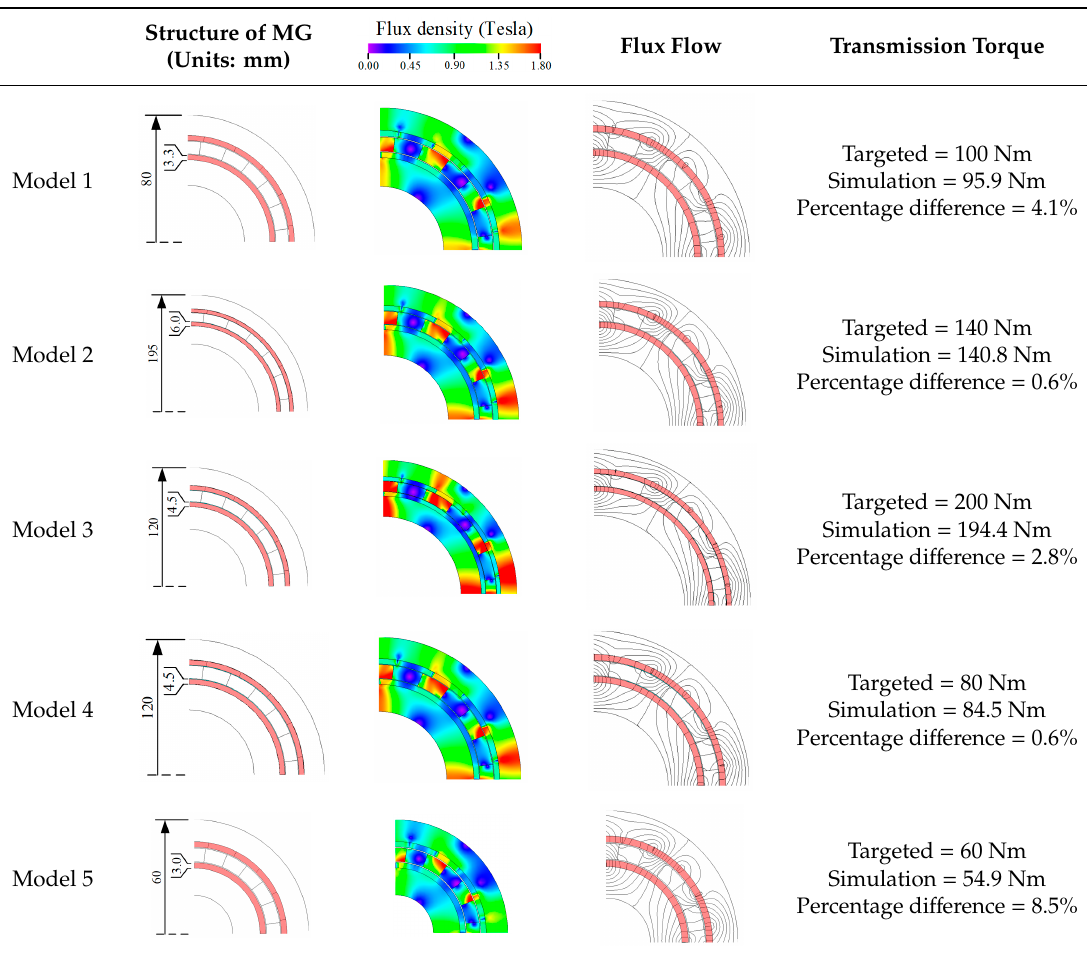
Table 3. The magnetic flux density and flux flow of the models.